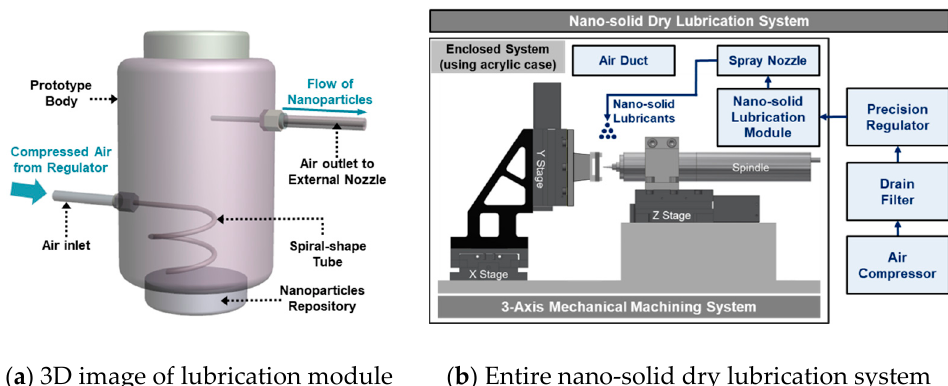
Figure 8. Nano-solid lubrication module and schematic diagram of entire nano-solid dry lubrica- tion system.